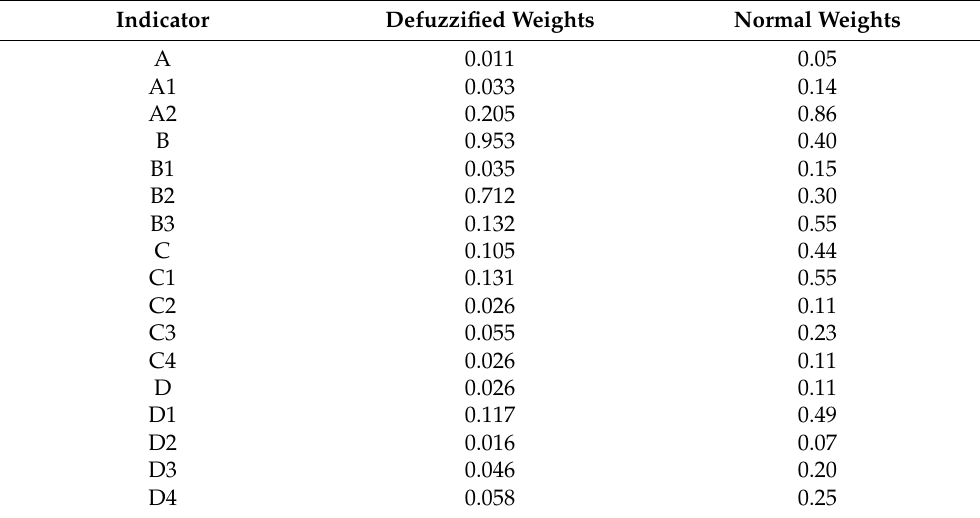
Table 9. Normal and defuzzified weights for the indicator system.